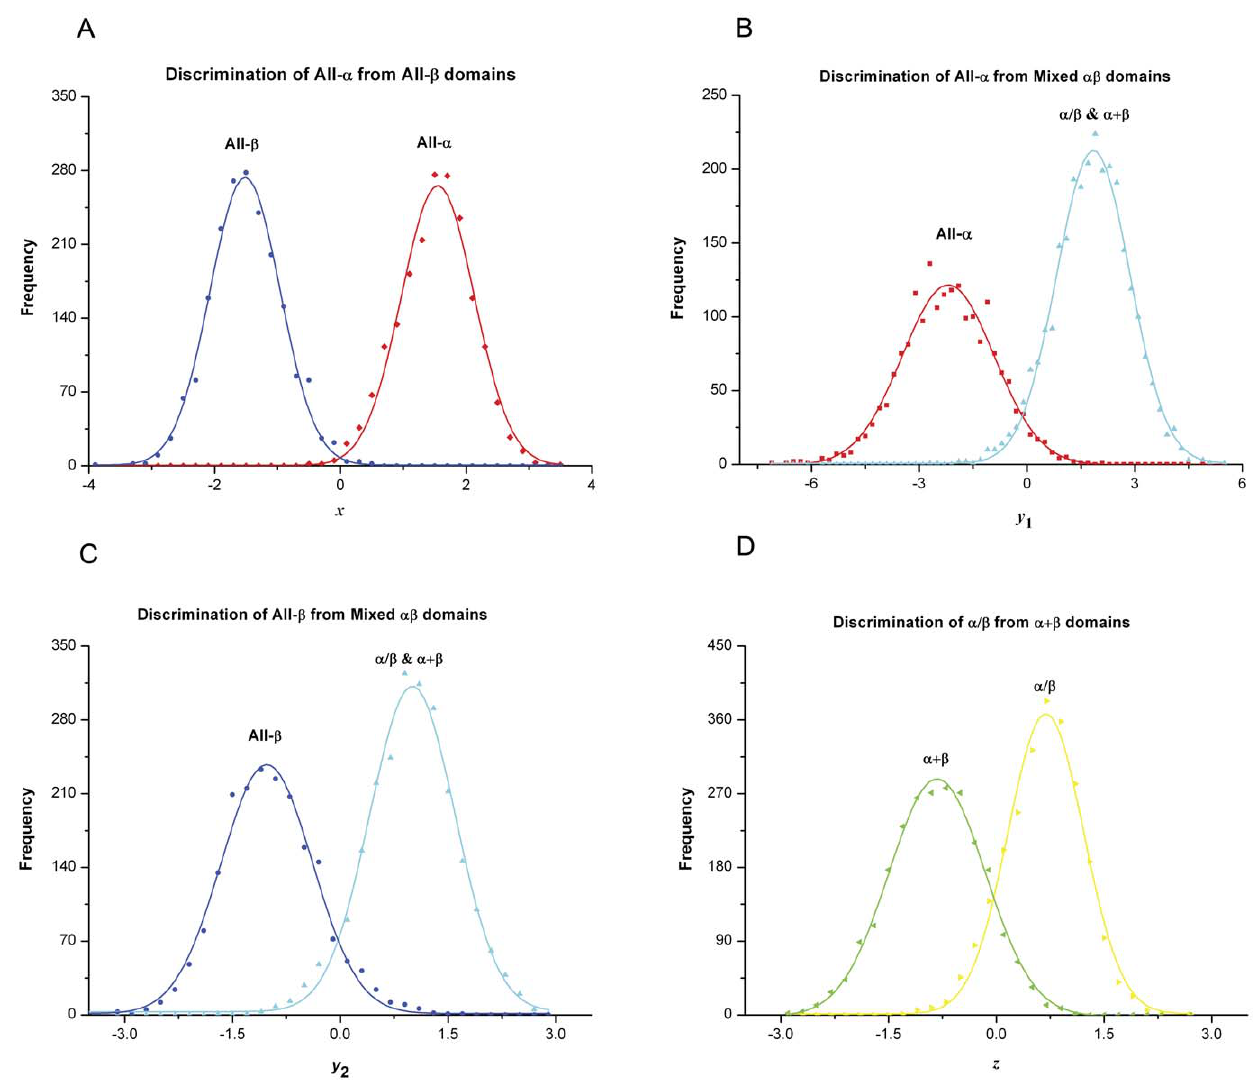
Figure 1. Discrimination of the protein domains between paired structural class groups. A) Discrimination of the all- a from all- b domains. B) Discrimination of the all- a from mixed ab domains. C) Discrimination of the all- b from mixed ab domains. D) Discrimination of the a / b from a + b domains.